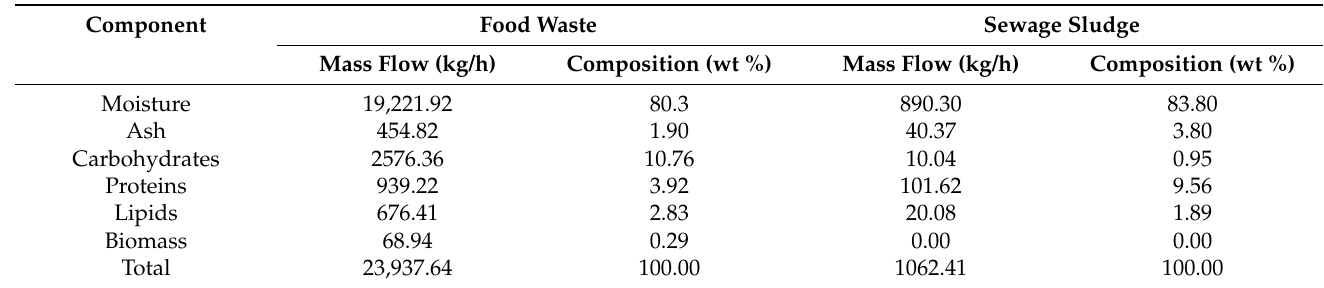
Table A1. FW and SS feed mass flow and composition in simulations.